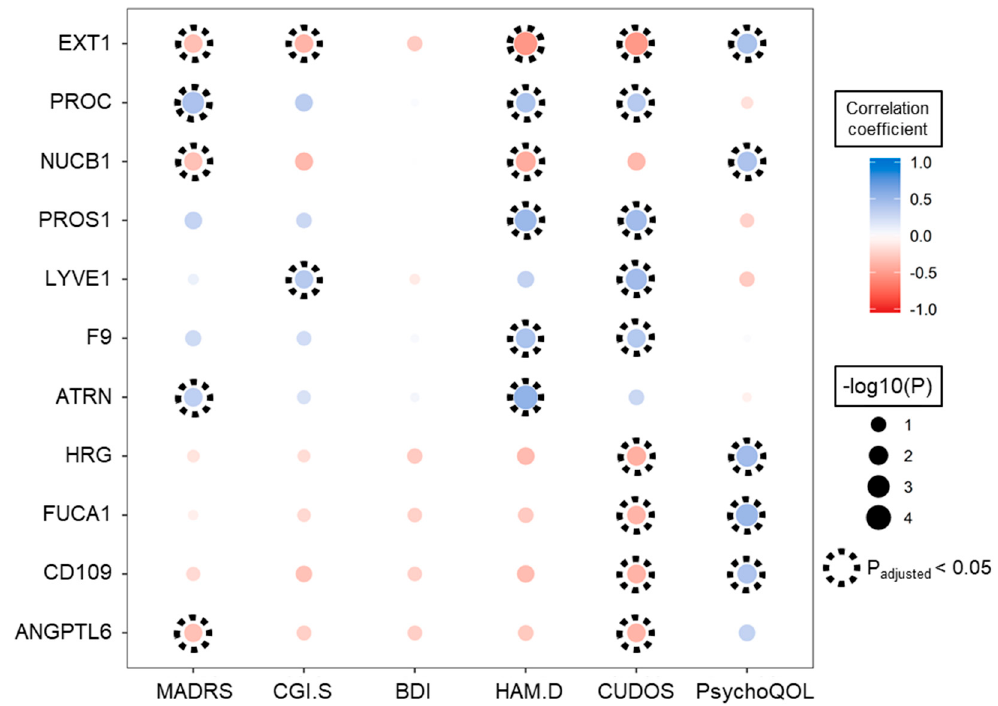
Figure 5. Plots showing correlations between the abundance of 11 plasma proteins and psychological indices; these 11 proteins correlated significantly with two or more of the six indices. Positive and negative correlation coefficients are colored blue and red, respectively, with the size of the bubble indicating the minus log10 adjusted p- value, and the dotted circles indicating significant correlation relationships (adjusted p -value < 0.05).